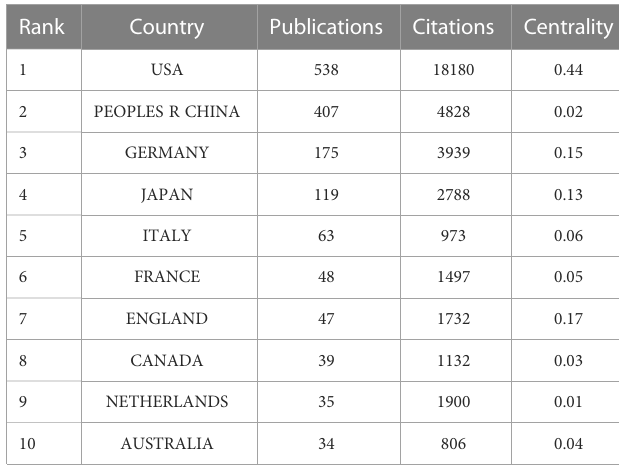
TABLE 1 Top 10 countries publishing research articles on immunotherapy for HNSCC.